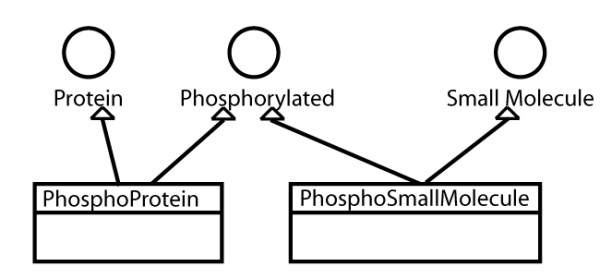
Illustration of the use of interfaces to express is-a relationships among biological concepts. Circles represent interfaces while boxes represent classes. An arrow from one class to an interface indicate that the class implement the interface, and this relationship can be used to indicate that instances of the class have the properties described by one or several interfaces.